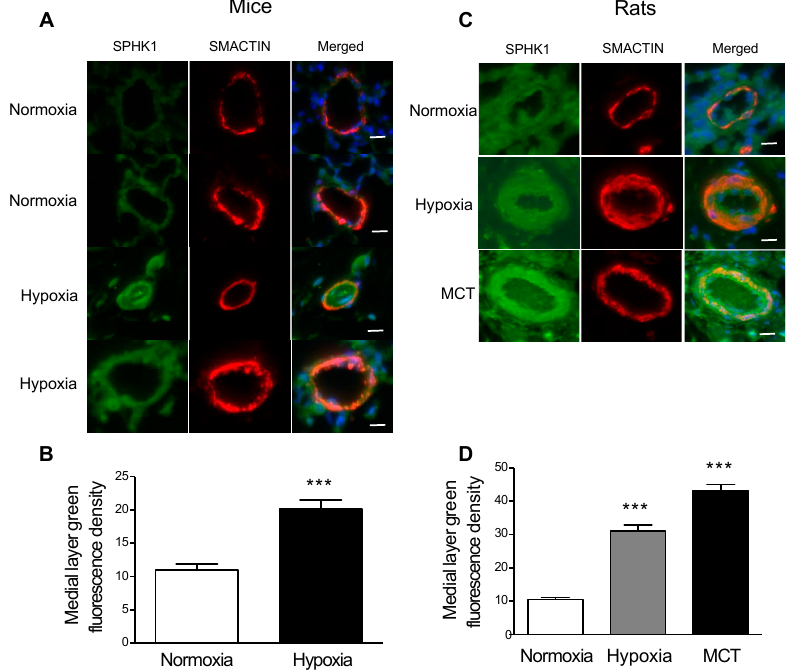
Figure 1. Lung immunofluorescence staining demonstrates increased SPHK1 expression levels in pulmonary artery smooth muscle cells in rodent models of pulmonary hypertension. ( A ) Mouse model of hypoxia-mediated pulmonary hypertension; ( B ) quantification data of medial layer SPHK1 expression levels for ( A ) via Image J version 1.4; ( C ) rat models of pulmonary hypertension mediated by monocrotaline or hypoxia; ( D ) quantification data of medial layer SPHK1 expression levels for ( C ) via Image J. n = 3; scalebar: 20 µm. *** p < 0.001 versus normoxia group. 2.2. Smooth Muscle Cell-Specific Sphk1 Knockout Mice Are Protected from Hypoxia-Induced PH Having demonstrated elevated SPHK1 expression in the lung tissues of rodent PH models, next, we investigated the effect of Sphk1 deletion in SMCs on the development of experimental PH in mice. The smooth muscle cell-specific knockdown of Sphk1 in PASMCs was achieved by breeding Sphk1 f/l mice with Tagln Cre + mice in the C57BL6 back- ground. The F2 generation mice were genotyped and their lungs were immunostained to confirm the deletion of SPHK1 expression in PASMCs. Sphk1 mRNA expression was measured in PASMCs isolated from the lung. Compared with control mice ( Sphk1 f/f ), Sphk1 f/f TaglnCre + mice were constitutively deficient in SPHK1 in the smooth muscle cell layer (Supplemental Figure S1). The deletion of Sphk 1 in smooth muscle did not induce PH under normoxic conditions (Figure 2). However, Sphk1 f/f TaglnCre - exposed to hypoxia had increased markers of HPH compared with normoxia-exposed mice as right ventricu- lar systolic pressure (RVSP); right ventricular hypertrophy (RVH, assessed by RV/(LV + S) ratio); and pulmonary vascular remodeling were increased. HPH development was in- hibited in the Sphk1 f/f TaglnCre + mice exposed to hypoxia for four weeks, as they exhibited lower RVSP, decreased RVP, decreased RVH, and decreased pulmonary vascular remod- eling compared with their hypoxia-exposed wild-type siblings, Sphk1 f/f TaglnCre − mice (Figure 2).